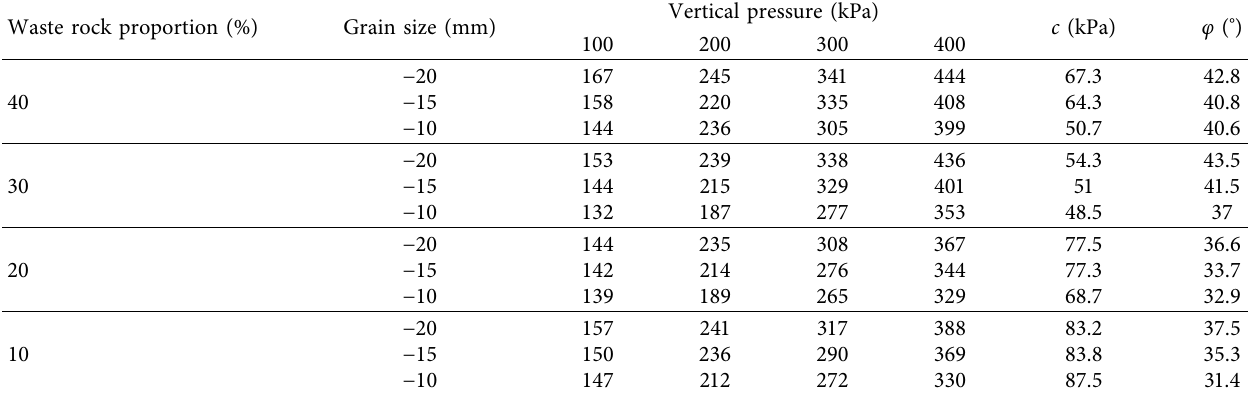
Figure 3: Shear test photos: (a) prepared specimens; (b) specimens destroyed. Table 1: Results of the shear strength test